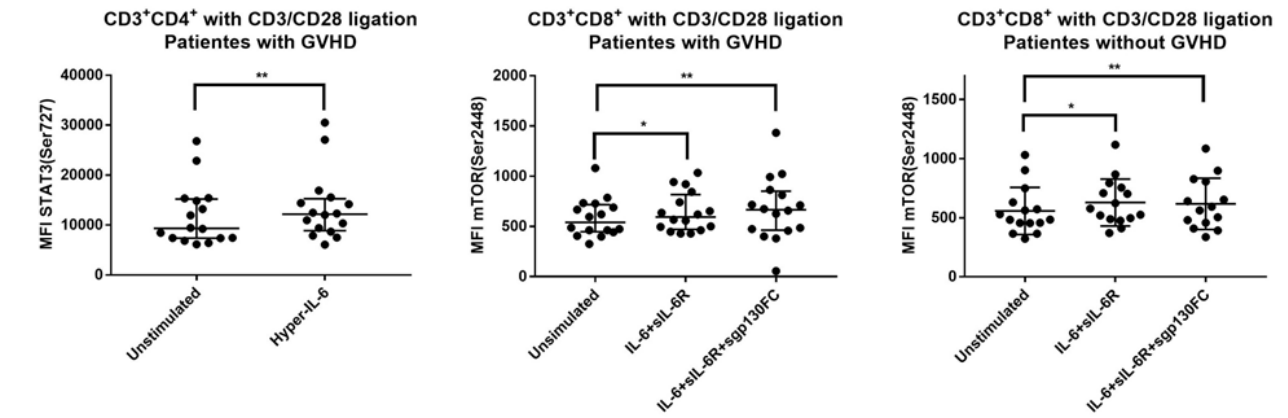
Figure 4. The effect of IL-6 stimulation on intracellular signaling in TCR-activated T cells derived from 31 allotransplant recipients on day +90 post-transplant. The T cells were stimulated either with hyper IL-6 (trans-signaling), IL-6+sIL-6R (classical and trans-signaling) or IL-6+sIL-6R+sgp130FC (classical signaling) in the presence of the T cell activation signal anti-CD3 + anti-CD28. The results are presented as the mean fluorescence intensity (MFI), and unstimulated refers to no IL-6 stimulation but only anti-CD3 + anti-CD28 activation. The figure presents the results for ( left ) effects on STAT3 (Ser727) phosphorylation of CD3 + CD4 + T cells derived from patients with GVHD stimulated with hyper-IL-6; ( center ) effects on mTOR (Ser2448) phosphorylation in CD3 + CD8 + T cells derived from patients with GVHD and stimulated with IL-6+sIL-6R or IL-6+sIL-6R+sgp130FC; and ( right ) effects on mTOR (Ser2448) phosphorylation in CD3 + CD8 + T cells derived from patients without GVHD and stimulated with IL-6+sIL-6R or IL-6+sIL-6R+sgp130FC. The Wilcoxon signed-rank test was used for the analyses. * indicates a p -value 0.05 to 0.01, ** indicates a p -value < 0.01.